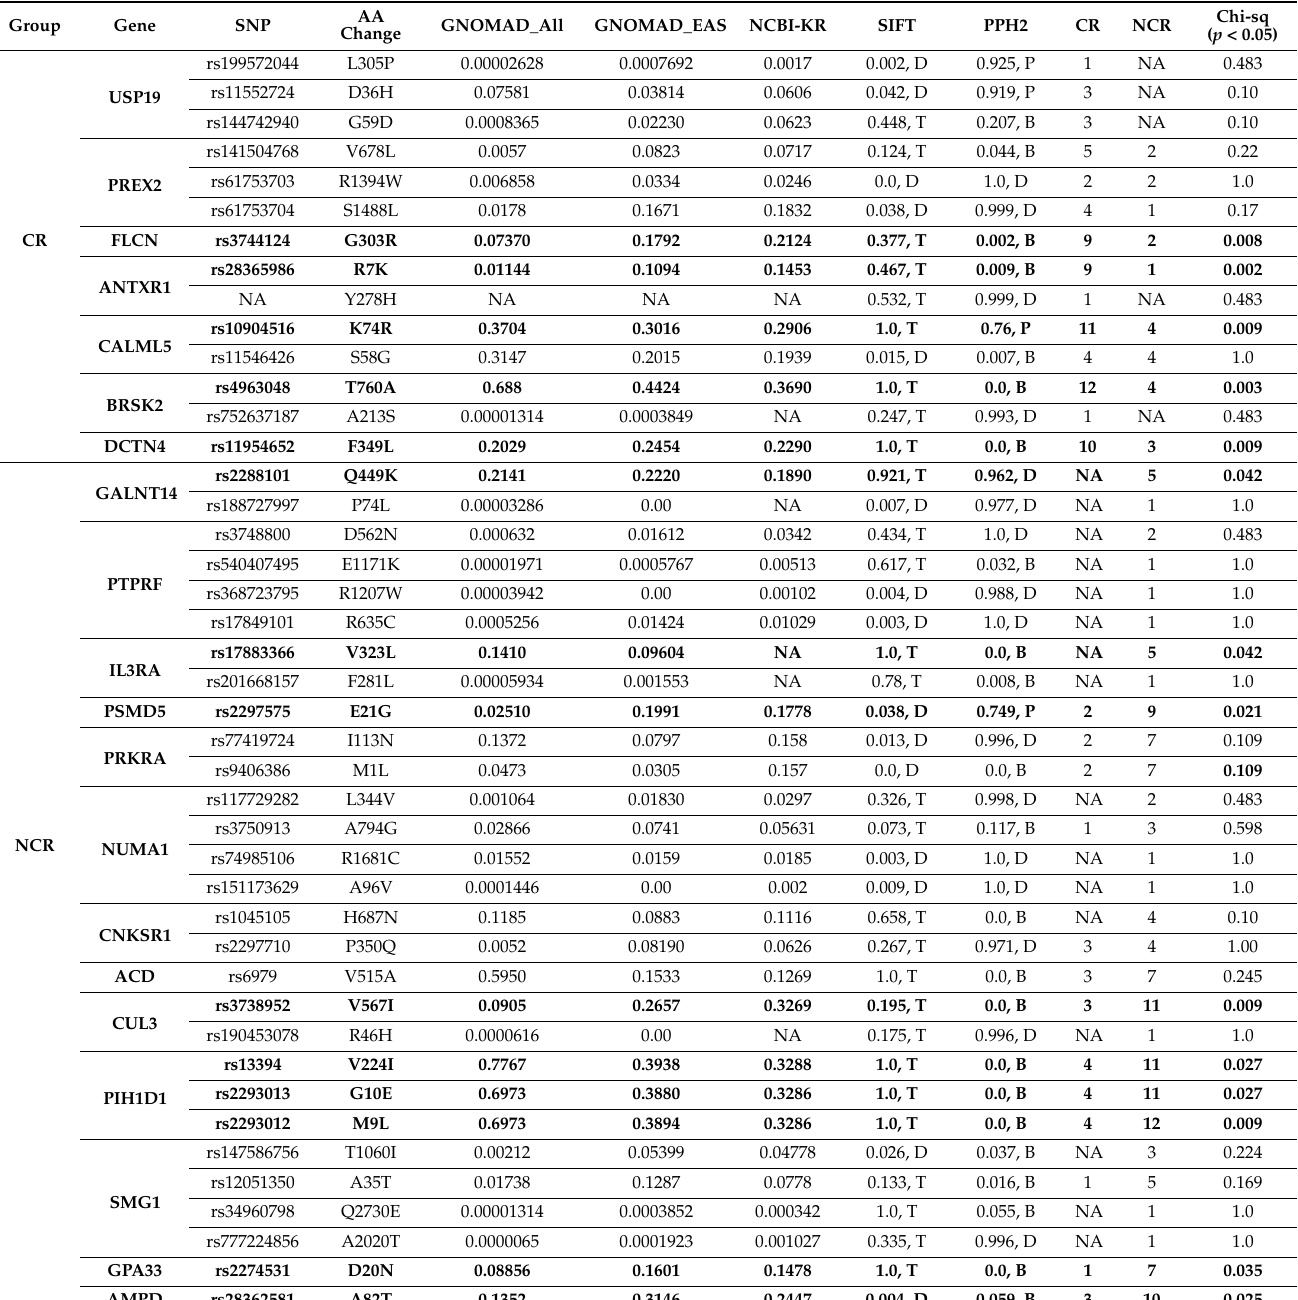
Table 3. Occurrence of variants in in CR and NCR